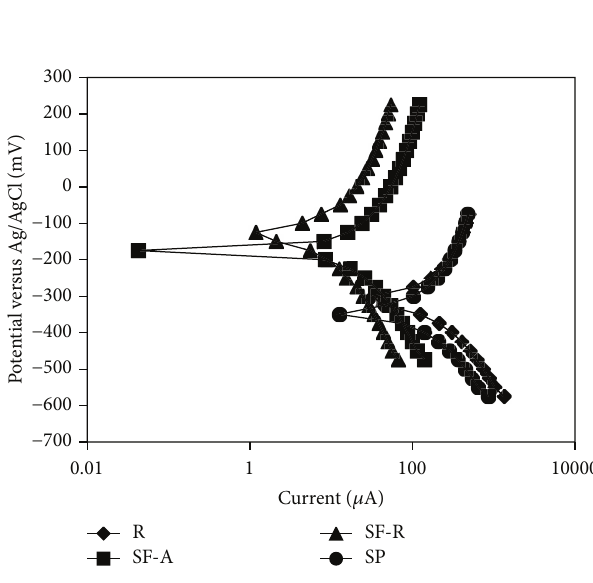
Figure 5: Polarization curves at 7 days of exposure.